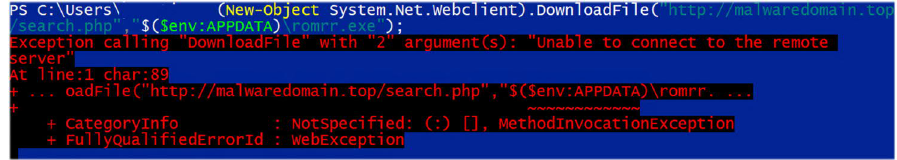
Fig 4. PowerShell blocked by Windows